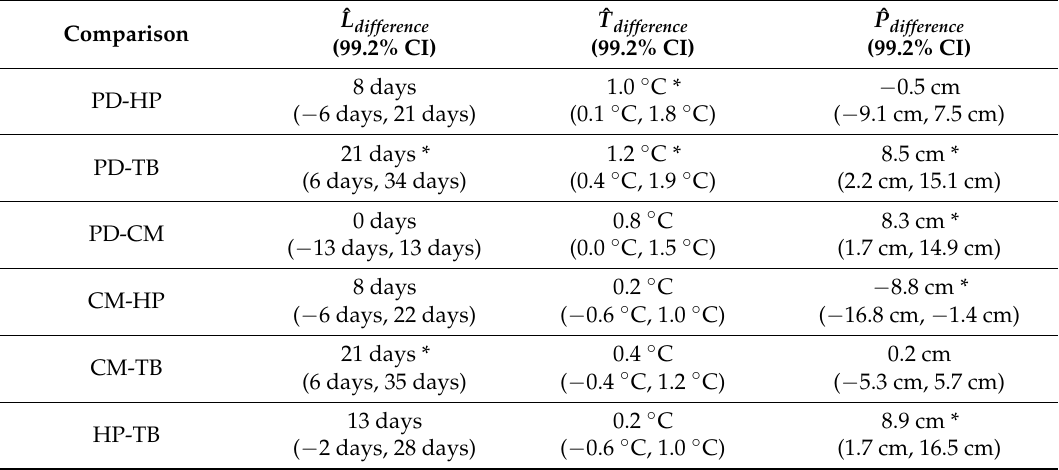
Table 7. Mesoclimate pairwise difference parameter